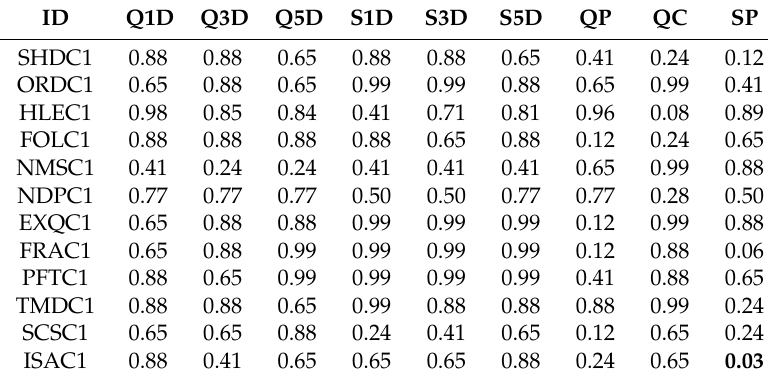
Table 5. p -Value of the KS test on runoff indices 1